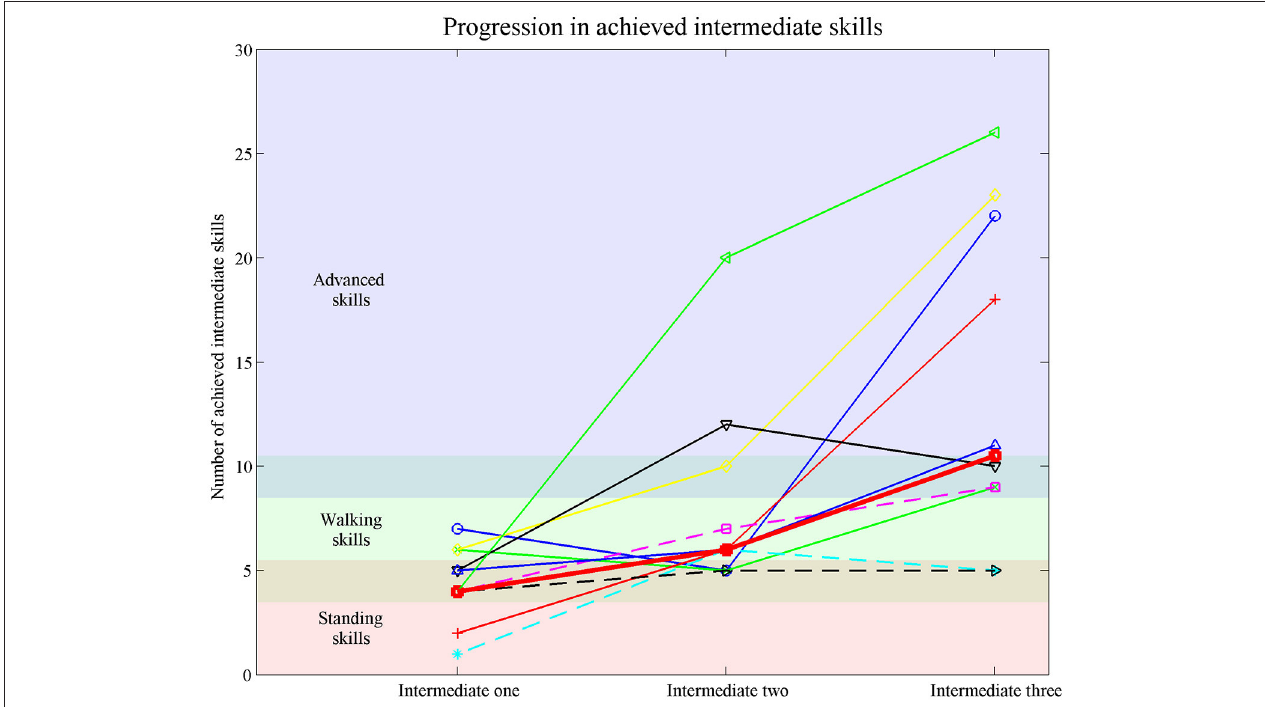
FIGURE 2 | Achieved intermediate skills measured with the Intermediate-skills-test one, two and three. Each line represents a participants. Thick red line represents the median achieved intermediate skills. Dotted lines represent participants who did not perform the Final-skills-test.